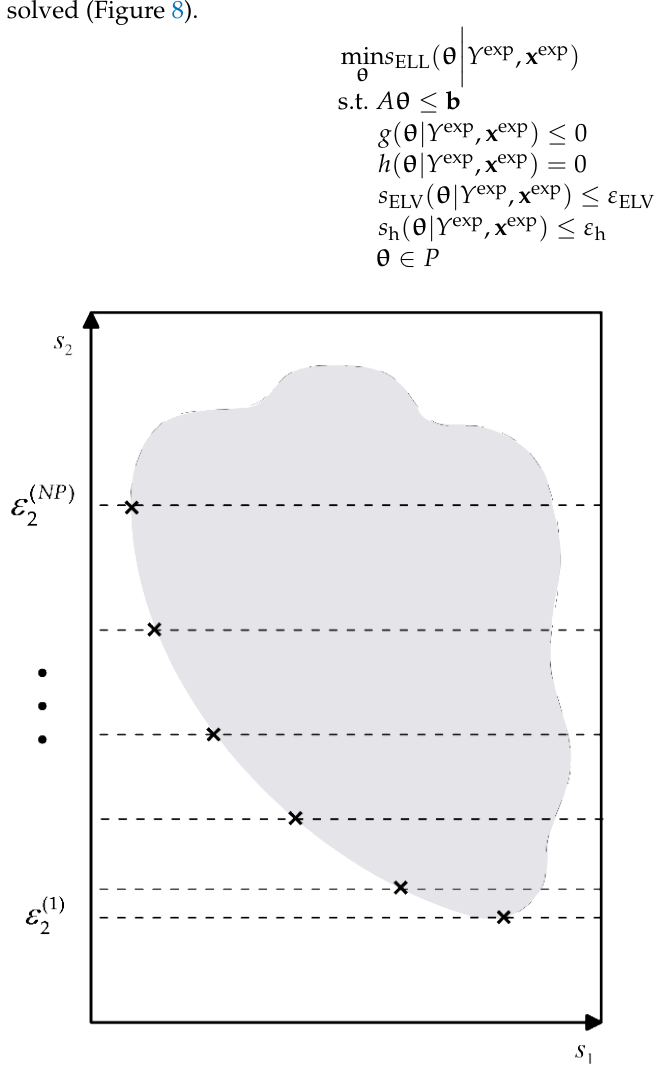
Figure 8. Construction of the efficient front applying the ε - constraint method. The front points are obtained by solving each restricted mono-objective subproblem (Equation (15)).